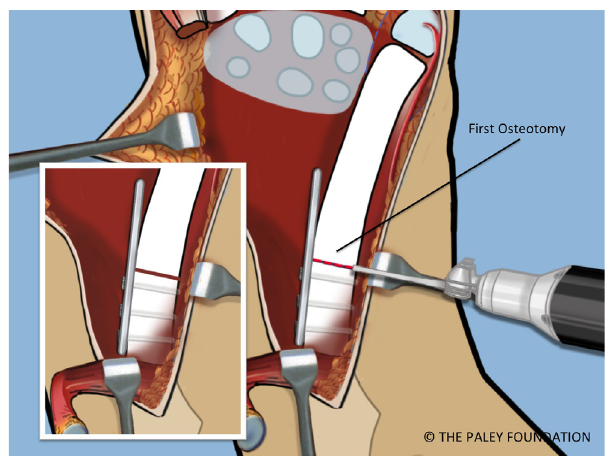
Figure 15. The proximal ulnar osteotomy is made using a saw.